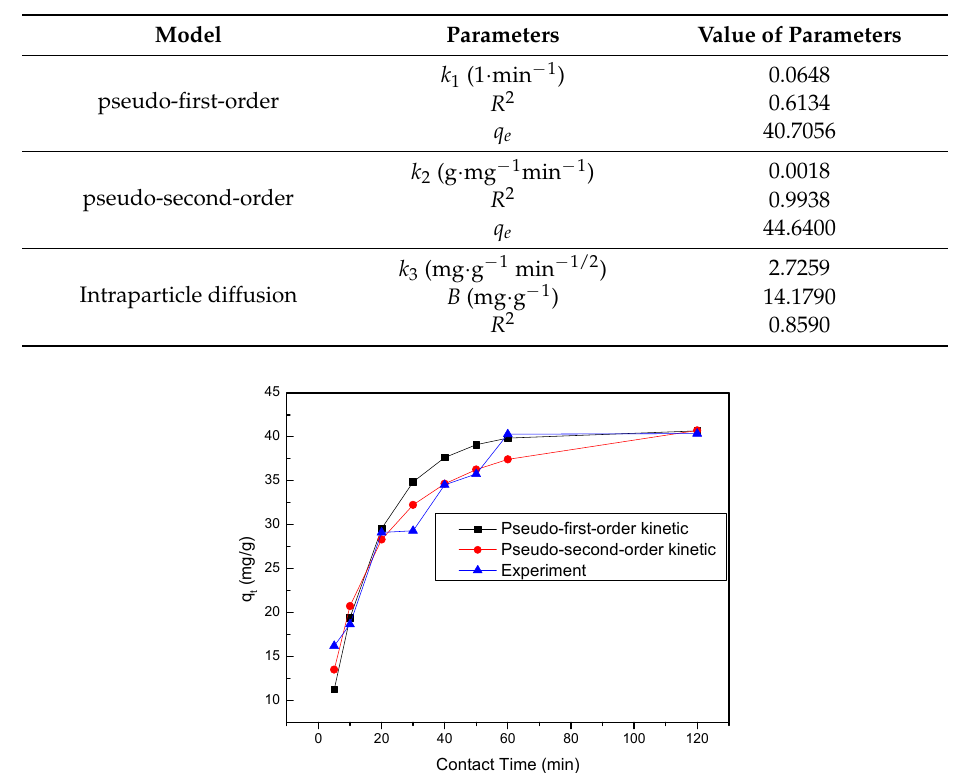
Table 8. Kinetic parameters for removal of the Se(IV) by the nZVI/rGO composites.